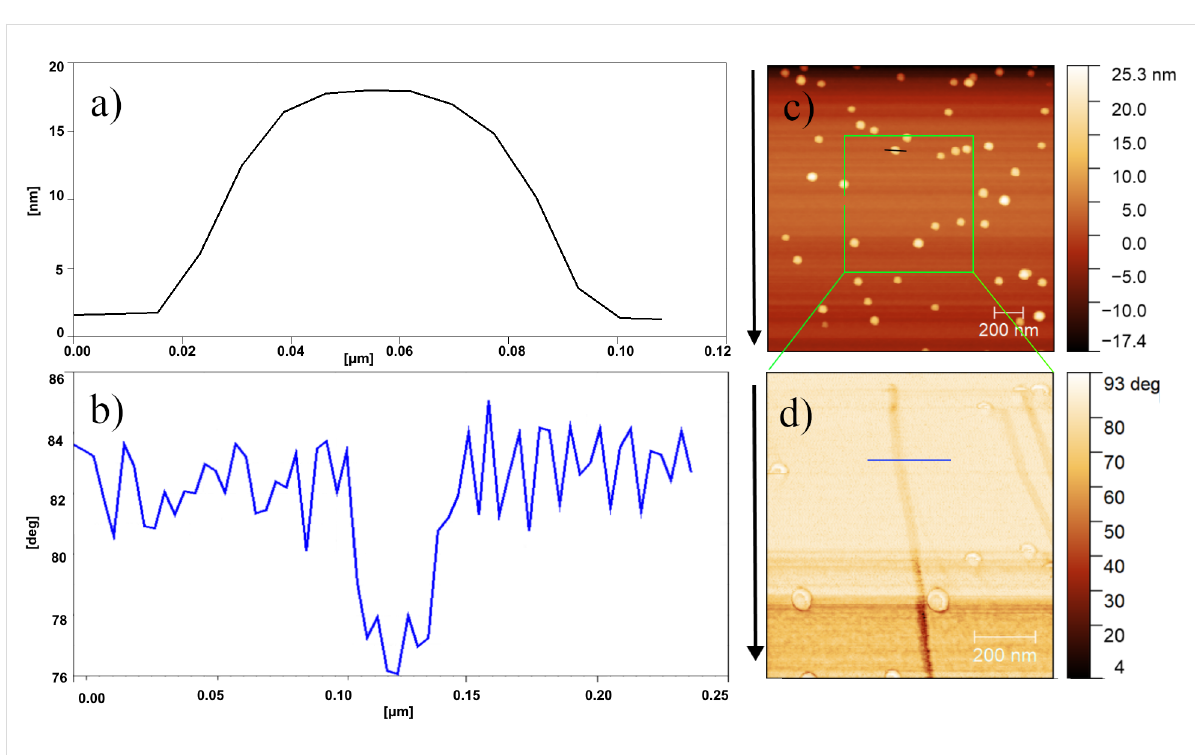
Figure 5: (a) Profile of a Au NP and (b) topography image of NPs on the Si substrate prior to manipulation. (c and d) Phase images recorded during the manipulation.